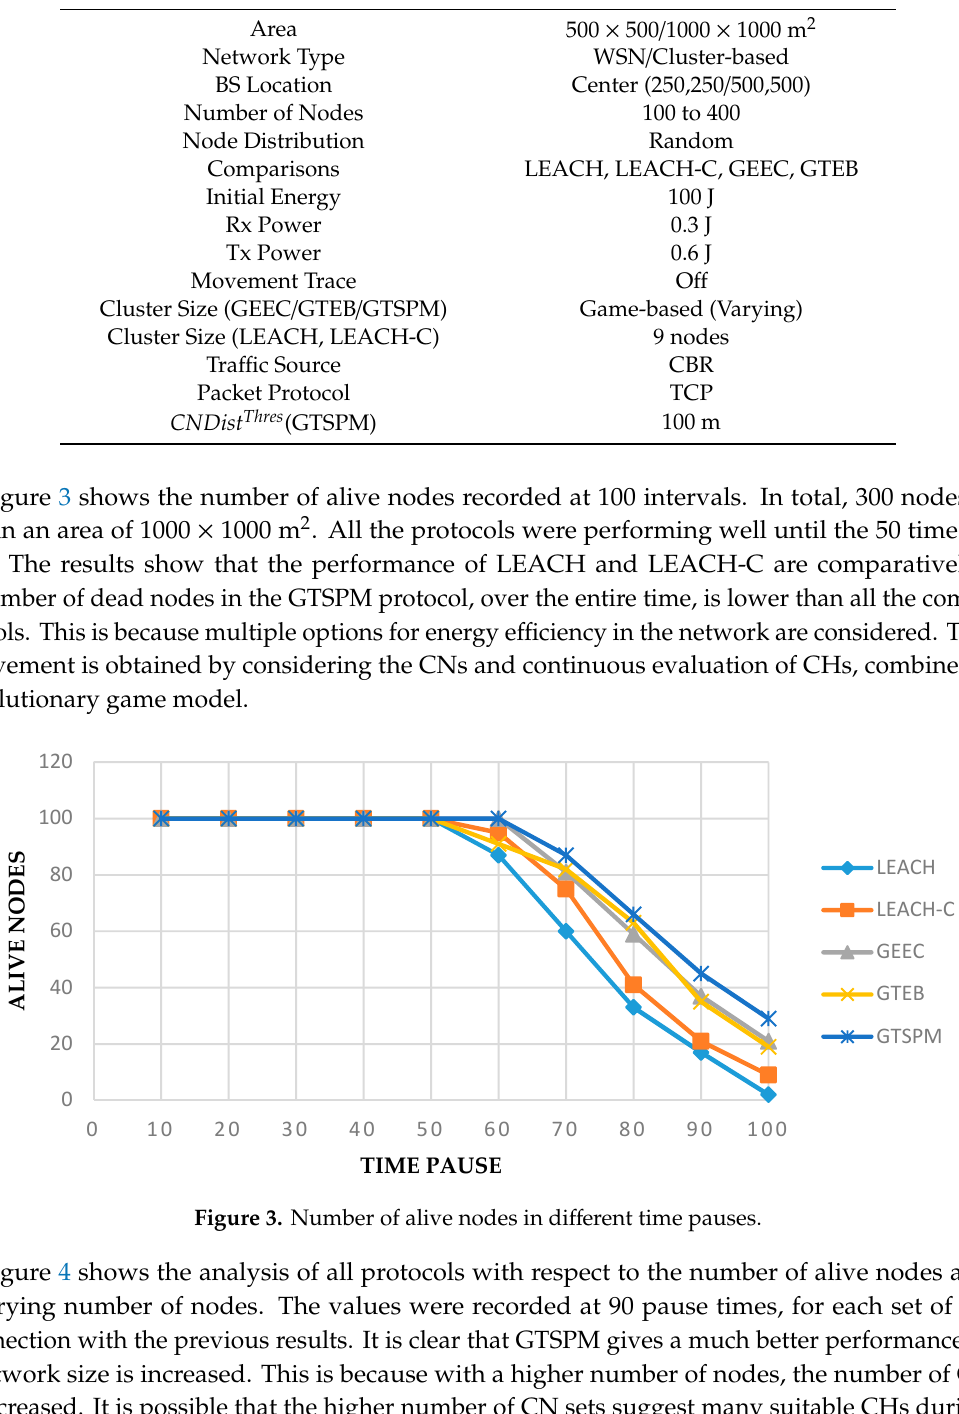
Figure 4. Number of alive nodes with varying number of nodes (pause time = 90).